Question: How would you classify this visualization?
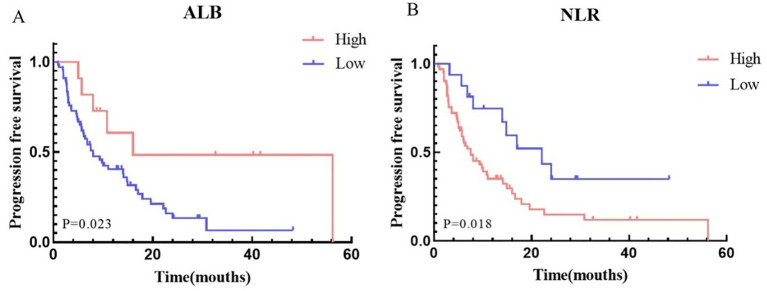
Answer: survival